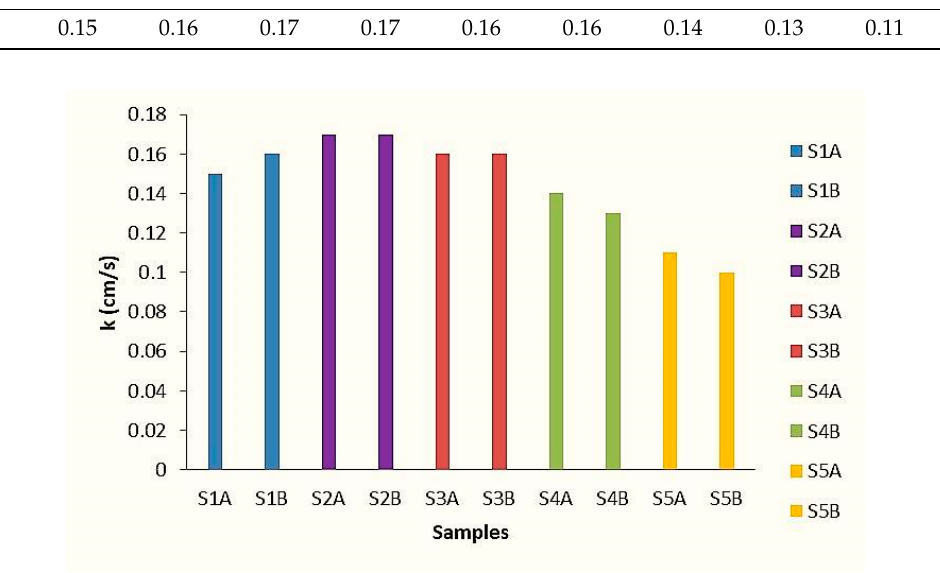
Figure 7. Permeability of the tested concrete specimens ( k coefficient (cm/s)).